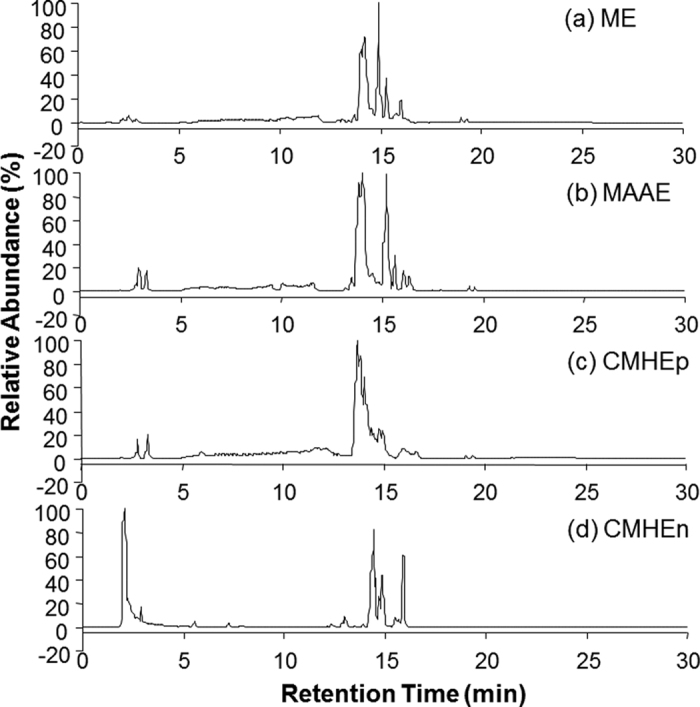
Base peak chromatograms (BPCs) for the four extracts: (a) methanol extract (ME), (b) MeOH/ACN/Acetone extract (MAAE), (c) polar fraction of CHCl3/MeOH/H2O extraction (CMHEp) and (d) non polar fraction of CHCl3/MeOH/H2O extraction (CMHEn), in positive ionization mode.